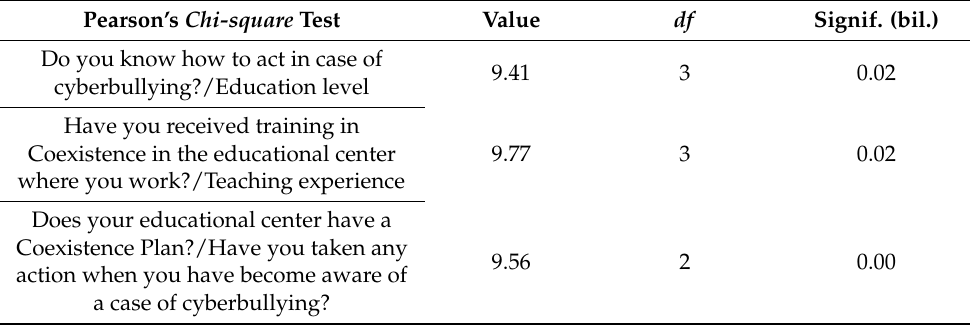
Table 15. Results derived from Pearson’s Chi-square test for independence. Pearson’s Chi-square Test Value df Signif.